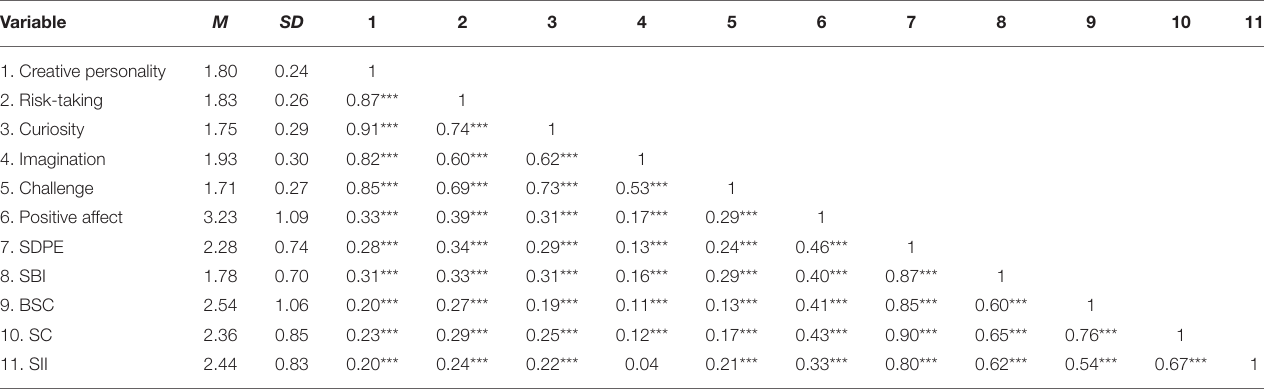
TABLE 1 | Means, standard deviations, and Pearson-correlations among variables. Variable